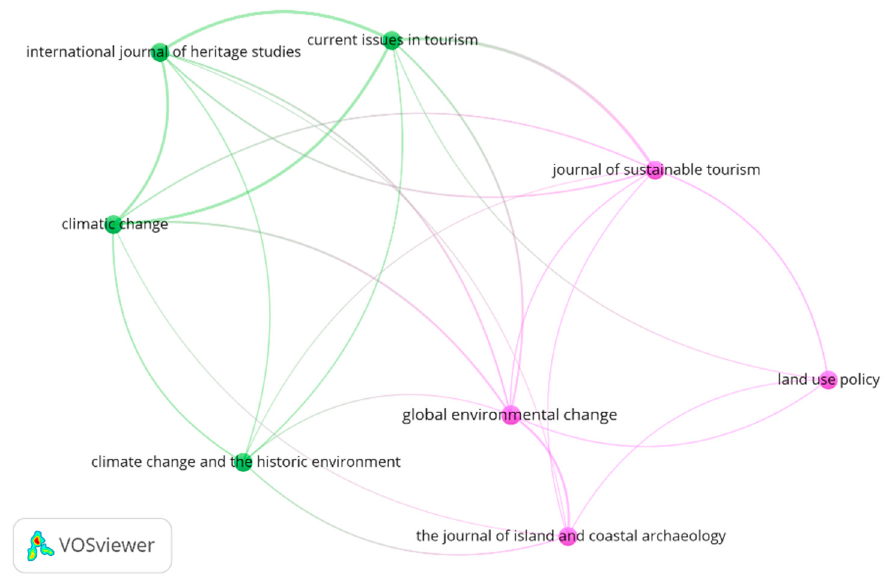
Figure 9. Journal co-citation analysis (JCA) in Scopus. Source: own elaboration.